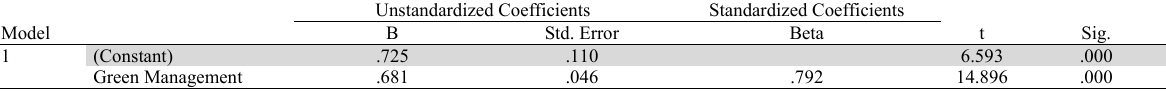
Simple Regression Analysis between green management as ID and sustainability analysis as DV